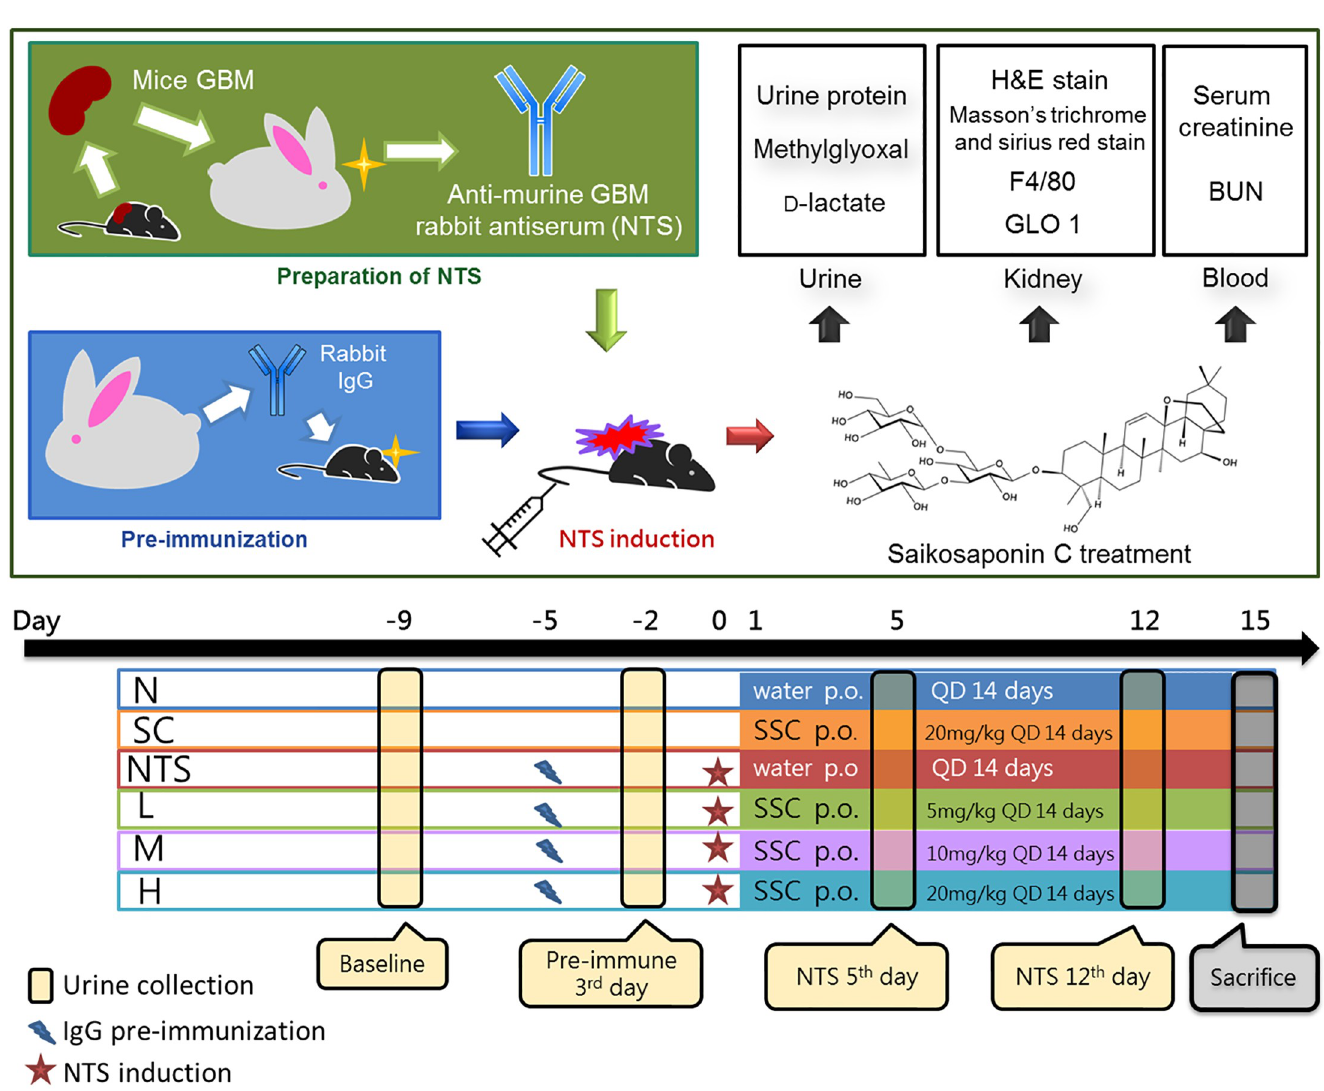
Fig 1. Schedule of the accelerated nephrotoxic serum nephritis model. Mice were divided into six groups ( n = 6): normal (N), NTS control (NTS) saikosaponin C (SSC) control (SC), SSC 5 (L), 10 (M), 20 (H) mg/kg/day. Mice in groups NTS, L, M, and H were pre-immunized by injection with rabbit IgG then were induced with 200 μ L NTS intravenous injection, while mice in groups N and SC were injected with normal saline. On the next day, mice in groups SC, L, M, and H were administered SCC once daily for 14 days. The urine was collected at four intervals for analysis of urine protein, methylglyoxal and D-lactate. The serum was collected for biochemical assays as serum creatinine and BUN. The kidneys were collected for histological examination (hematoxylin and eosin, Masson’s trichrome, and sirius red stain), immunoblotting analysis of glyoxalase 1 (GLO 1), and immunohistochemistry analysis of F4/80.